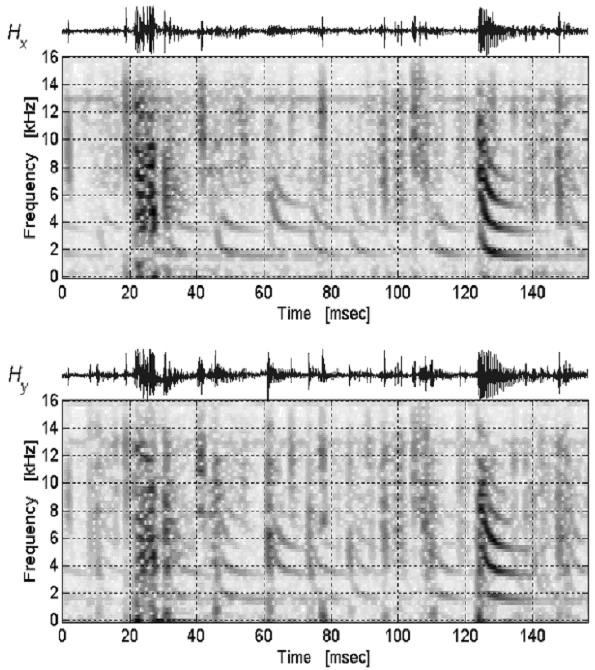
Fig. 9. Series of tweeks in a cut of a two-channel, crossed- loop broadband VLF recording at Marion Island (22 April 2001, 02:30:07 UT). Tweeks in the above panel (NS oriented loop) are ap- pearing without the TEM mode, in agreement with an almost merid- ional spheric propagation to the receiver according to our modelling (with kind permission of A. R. W. Hughes, Durban, South